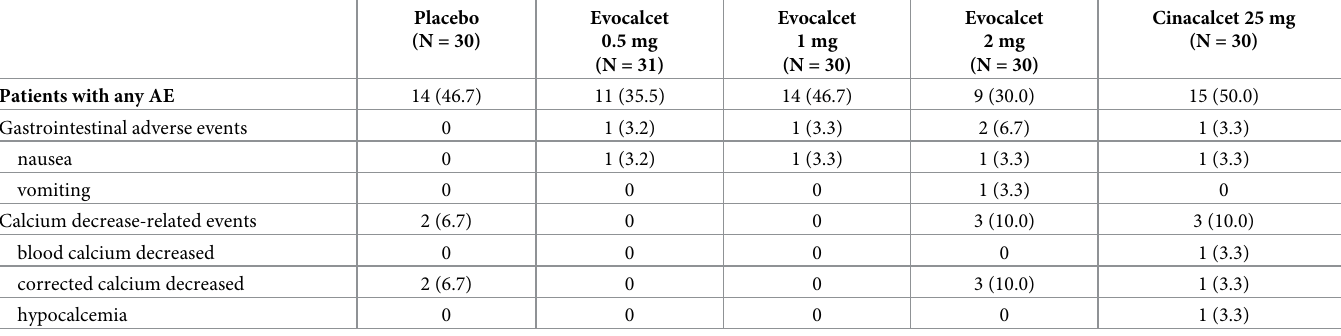
Table 3. Summary of gastrointestinal adverse events and calcium decrease-related events.